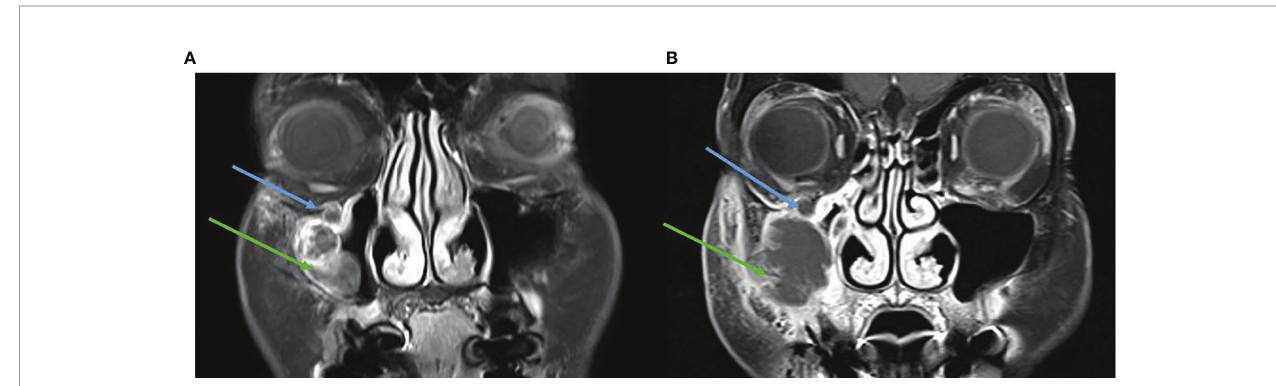
FIGURE 7 | (A) Baseline, left, MRI post contrast T1 Fat Sat demonstrating a destructive lesion involving the anterior wall of the right maxillary sinus (green arrow) and perineural spread in the right infraorbital nerve (blue arrow). (B) MRI post contrast T1 Fat Sat, post three cycles of cemiplimab 250 mg/3-weekly, enlarging destructive mass and persisting perineural spread.